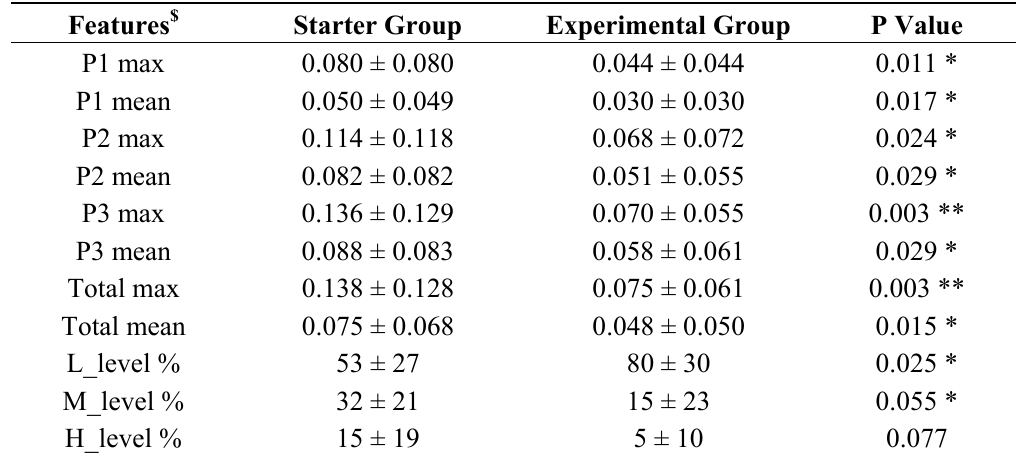
Table 3. Statistical and t-test results between starter group and experiment group. Data is represented as average (standard